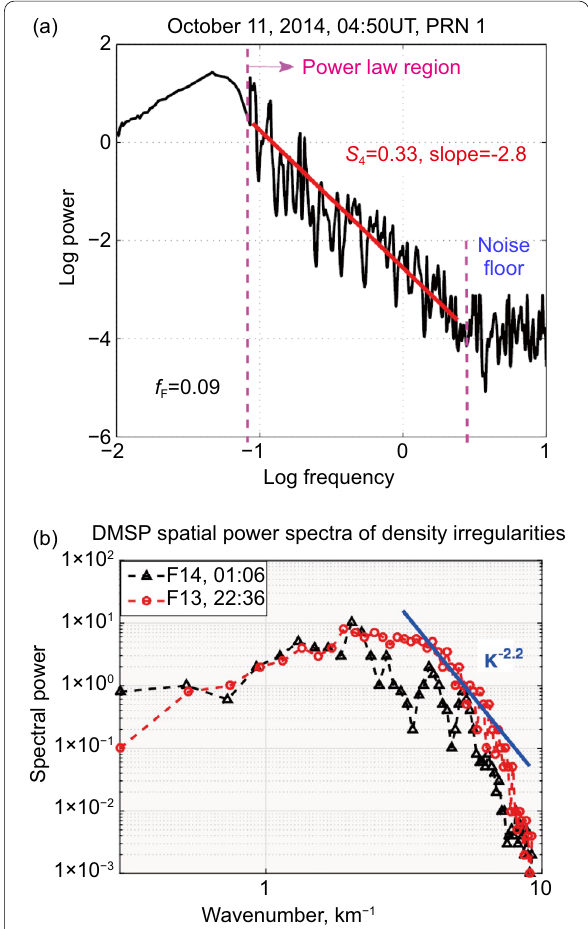
Fig. 10 a Power spectral of midlatitude GPS amplitude scintillation in October 2014. Spectal index p = − 2.8 and fresnel scale is 0.09 Hz. b Power spectral of in situ density irregularities observed by DMSP satellites F13 and F14 observed in September 2001 during a period of GPS scintillations. The spectral index of 2.2 is observed (Adapted − from Eltrass et al.